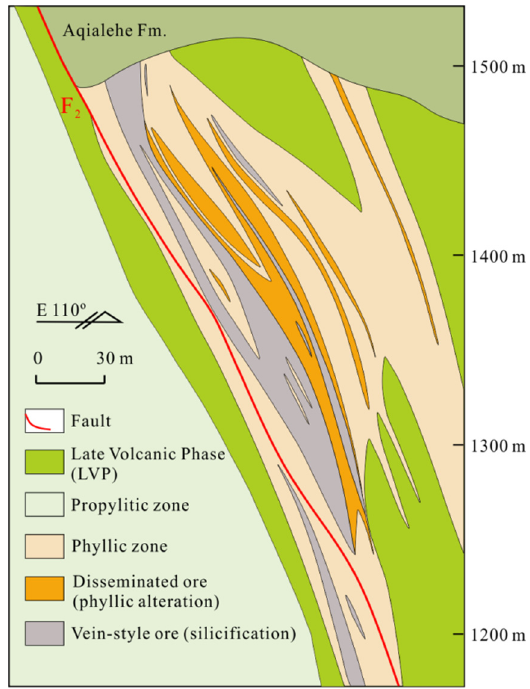
Figure 2. Representative cross-section (Line 48 on Figure 1b) illustrating the spatial relationships among orebodies, alteration, and fault in the Axi deposit. After Liu et al. [37].